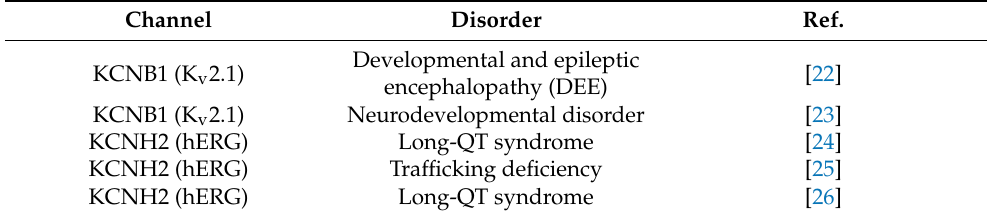
Table 1. Automated patch-clamp applications in BrS-related ion channel